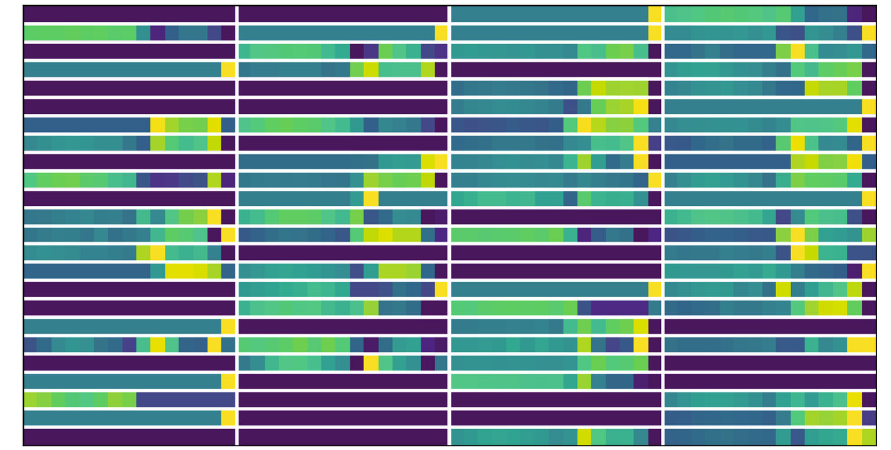
Figure 17: Feature visualization of the third convolution layer (96 in